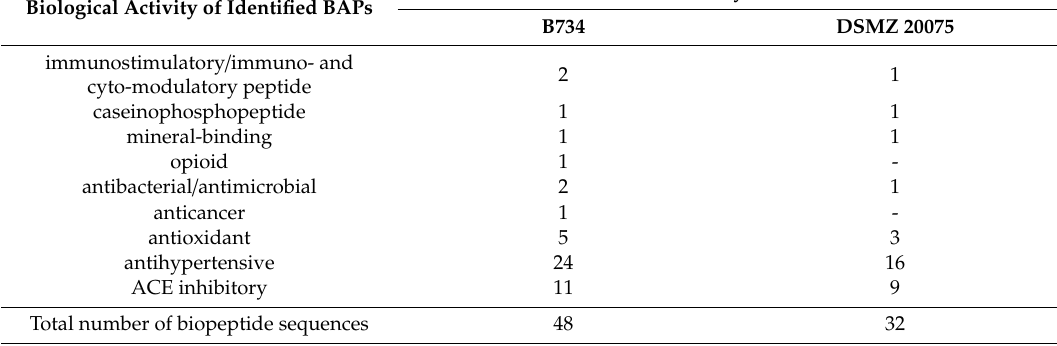
Table 4. Comparison of the number of biologically active peptides (BAPs) sequences generated by the tested strains of Lb.